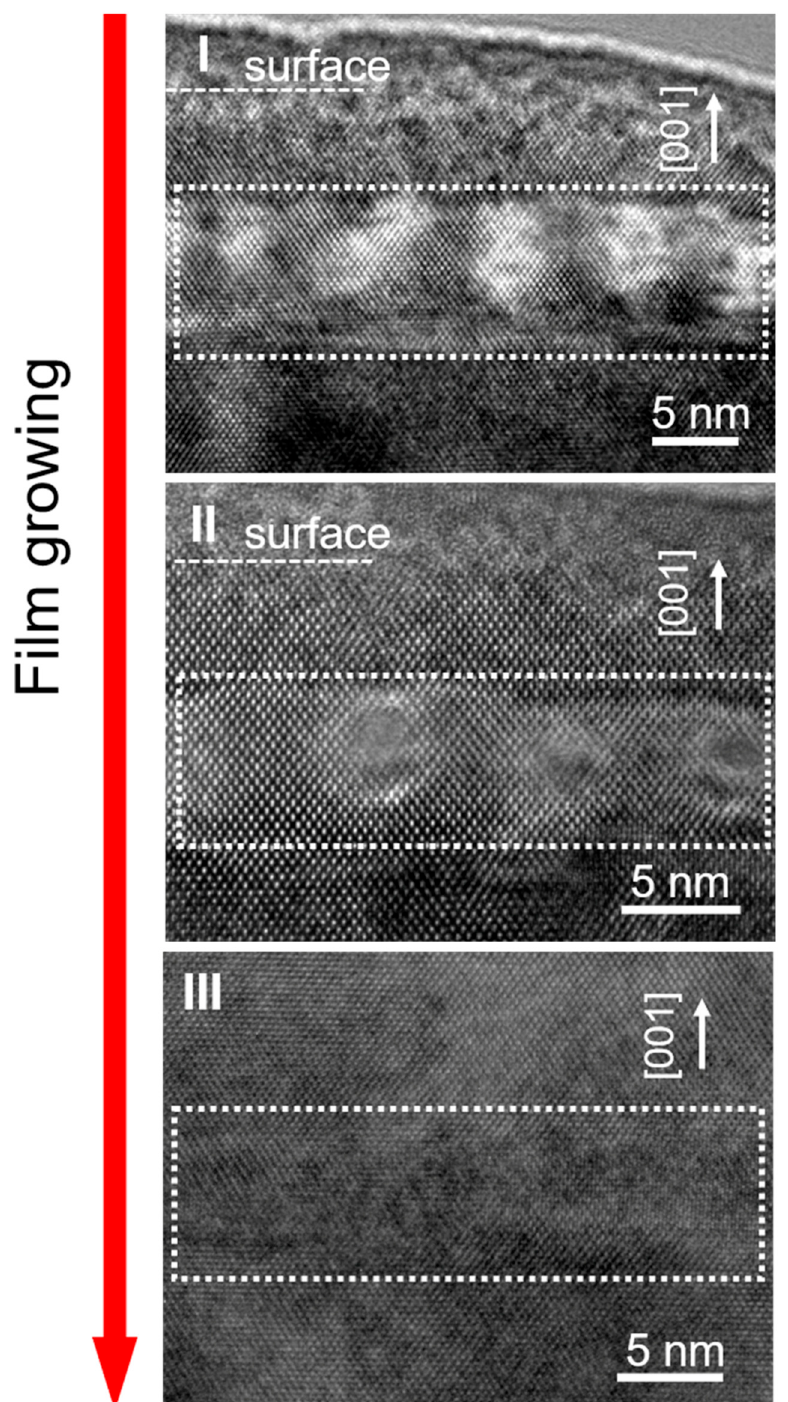
Figure 4. [110]-zone cross-sectional HRTEM images of the pure Ge film intermediate products, which actually show the process of non-typical strain relaxation for Si 1 − x Ge x films grown by LT-MBE. Figure 5 shows the schematic 2D model of the Si 1 − x Ge x thin films grown on Si (001) relaxing strain through typical strain relaxation mechanism in an MBE grown heterostructure (circled in black on the left) together with the non-typical strain relaxation mechanism in an LT-MBE grown heterostructure (circled in black on the right). Red lines indicate the dislocations in the Si 1 − x Ge x film. Blue lines indicate the local shearing at interfaces of multiple-layered structures. And the formation of multiple-layered structures refers to the formation of short islands along [-110] direction and then the short islands will afterwards crystallize into a single-crystalline structure. The light grey cubes near the Si 1 − x Ge x film surface indicate the short islands. Here, the low TDD of Si 1 − x Ge x film may be